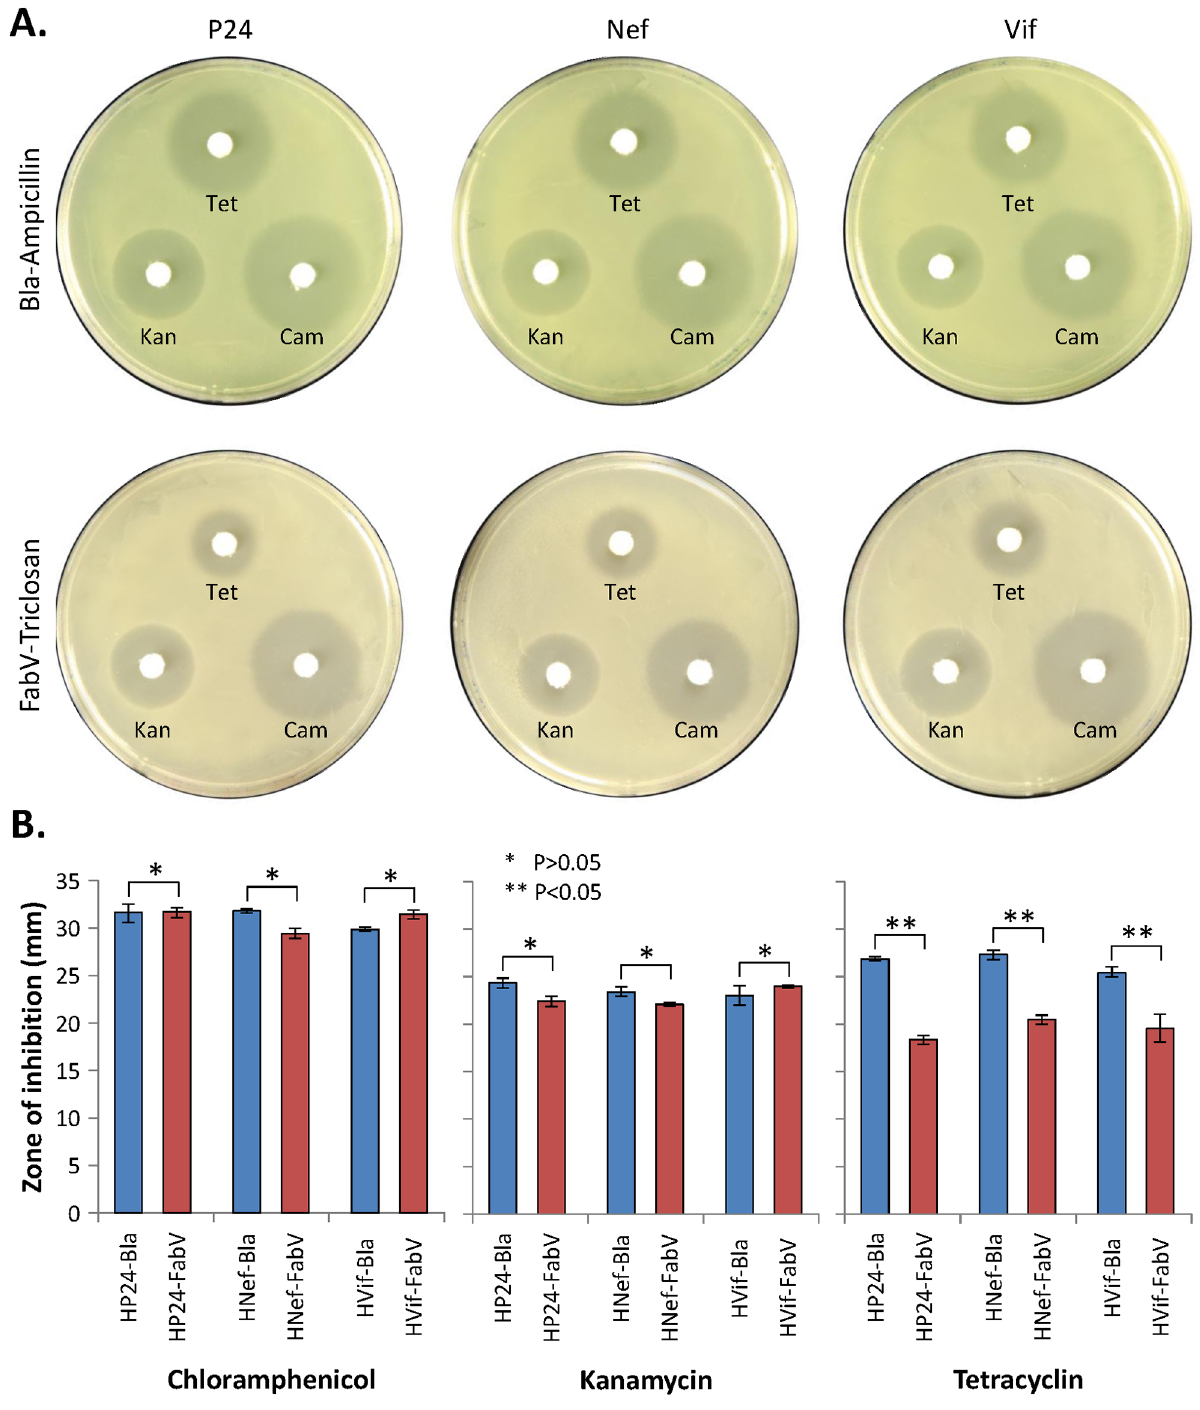
Fig 7. FabV-Triclosan selection system is compatible with other antibiotics. BL21(DE3) harboring Bla or FabV vectors were spread on agar plates containing either Ampicillin or Triclosan. Antibiotic sensitivity discs impregnated with Chloramphenicol (25 μ g), Kanamycin (50 μ g), or Tetracycline (10 μ g) were placed. Following overnight incubation, zones of inhibition were measured and compared between the two selection systems. Error bars show standard deviations calculated from at-least three independent experiments each performed in duplicate.